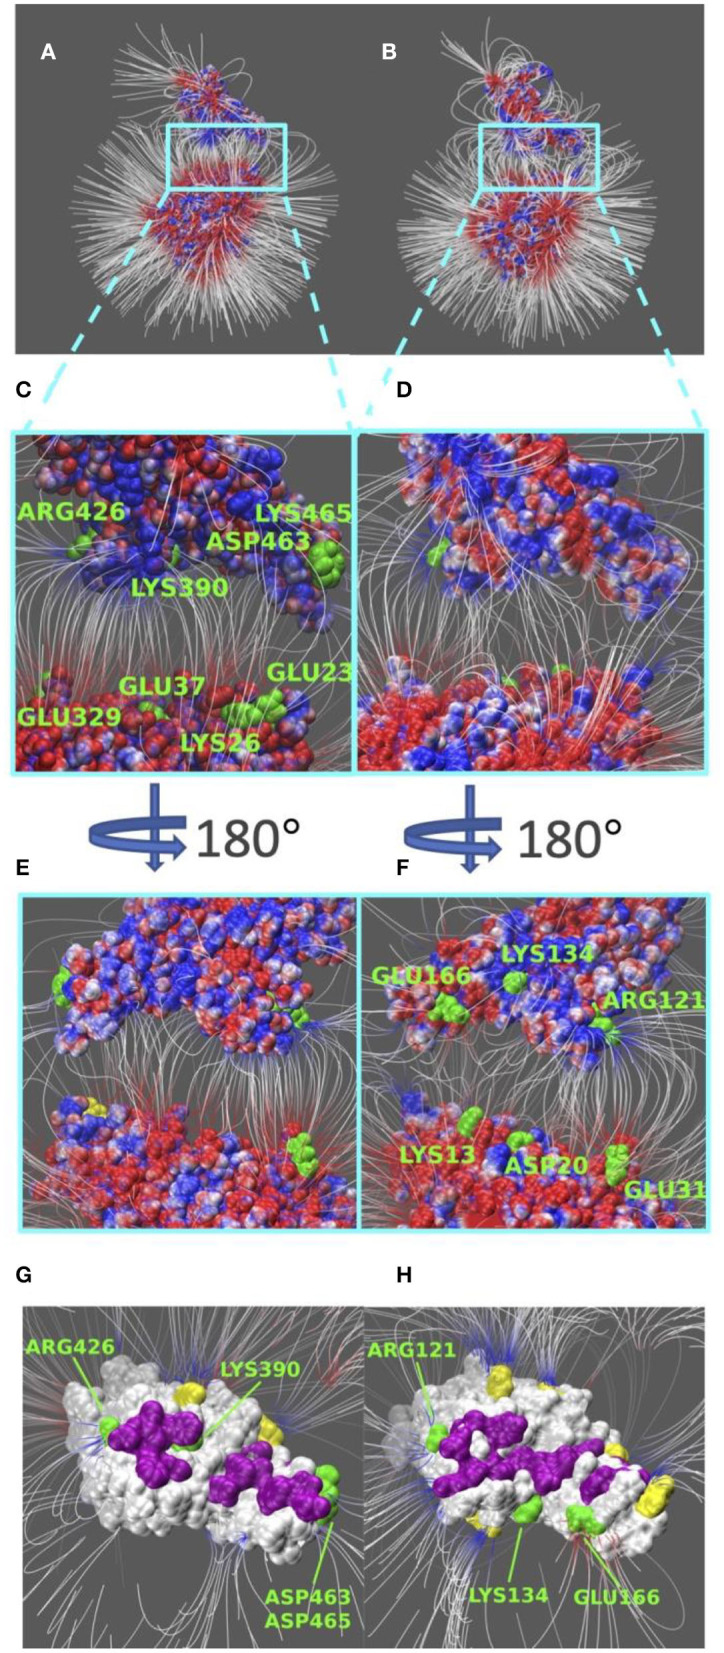
Electric filed lines at the interfaces of S protein RBDs and ACE2. (A) An overview of electric filed lines between SARS-CoV S protein RBD and ACE2 RBD; (B) An overview of electric field lines between SARS-CoV-2 S protein RBD and ACE2 RBD; (C) A closeup view of (A), with marked key residues that form salt bridges (ARG426-GLU329, LYS390-GLU37, ASP463-LYS26, LYS465-GLU23); (D) A closeup view of (B); (E) The back view of (C); (F) The back view of (D) with marked key residues that form salt bridges (GLU166-LYS13, LYS134-ASP20, ARG121-GLU31). The electrostatic surfaces and field lines are rendered by Visual Molecular Dynamics (VMD) (Li et al., 2013) with a color scale from −1.0 to 1.0 kT/Å. To present field lines in the clearest way, we adjusted gradient values to 2.39 kT/(eÅ), in (A,B, E,F), and 2.08 in (C,D,G,H). Negatively and positively charged areas are colored in red and blue, respectively; (G) The bottom view of SARS-CoV S protein RBD, salt bridge involved residues are marked green, hydrogen bond involved residues are marked purple, and yellow regions are special residues that have high density of field lines but they are not involved in salt bridges nor hydrogen bonds; (H) The bottom view of SARS-CoV-2 S protein RBD, salt bridge involved residues are marked green, hydrogen bond involved residues are marked purple, and yellow regions are special residues that have high density of field lines but they are not involved in salt bridges nor hydrogen bonds.